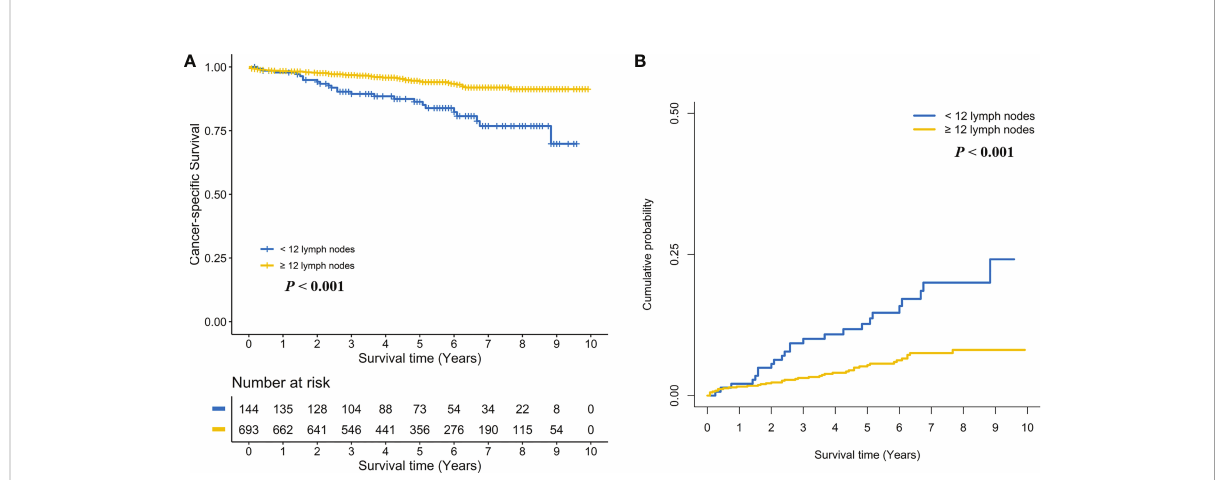
FIGURE 4 Comparison of cancer-speci fi c survival (A) and cumulative probability of cancer-speci fi c death (B) in pT2N0 rectal cancer patients between < 12 and ≥ 12 lymph nodes